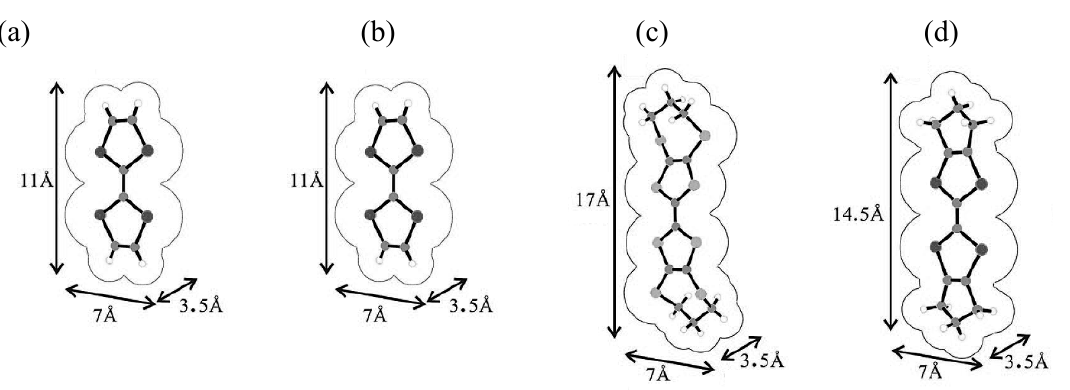
Figure 32. The structures of supramolecular assemblies with van der Waals outlines.